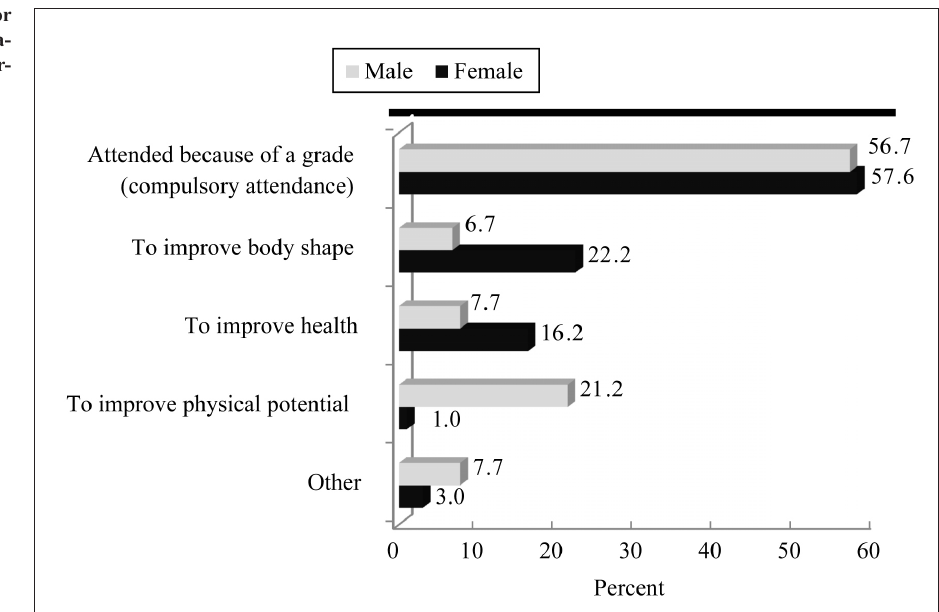
Figure 1. Main reasons